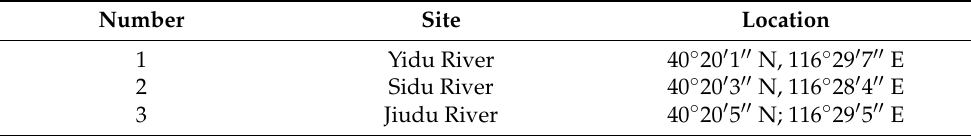
Table 1. The sampling sites for DNA primer